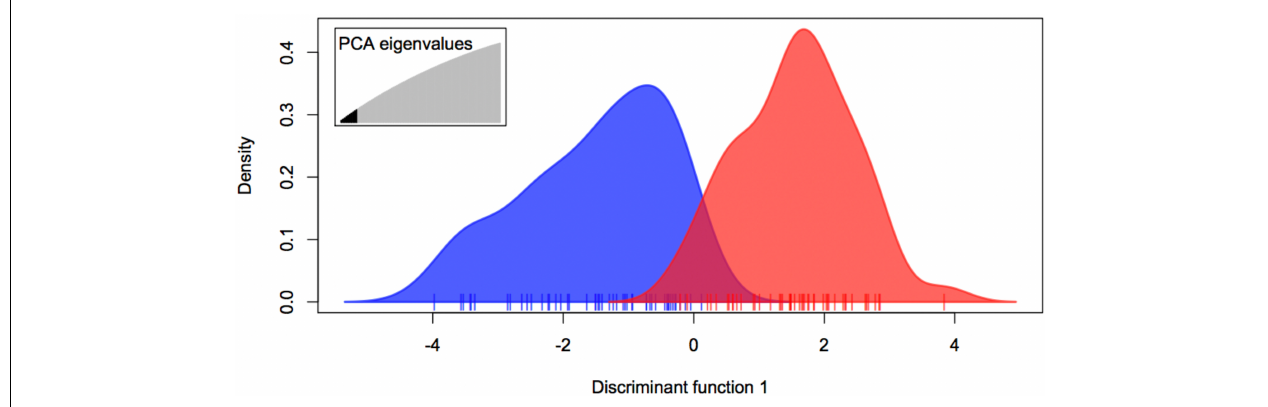
FIGURE 5 | Discriminate Analysis of Principle Components (DAPC) for expected-season (blue) and late-season (red) megalopae recruits in 2014 in Coos Bay, Oregon using both presumably neutral (1,913) and putatively adaptive (2) loci using PC 1 through PC